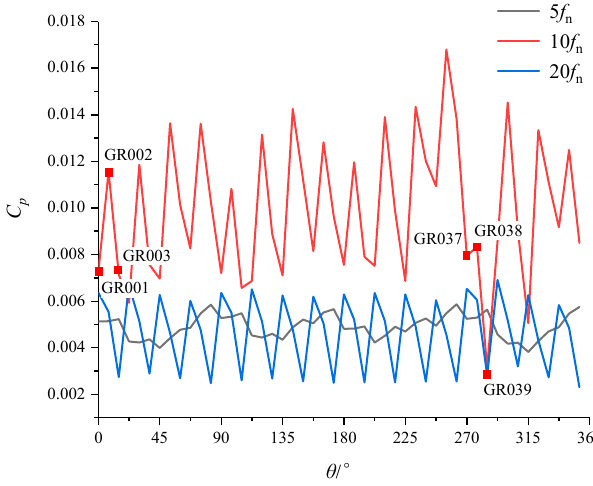
Figure 15. Circumferential distribution of rotor–stator interaction amplitudes at 1.0 Q d .